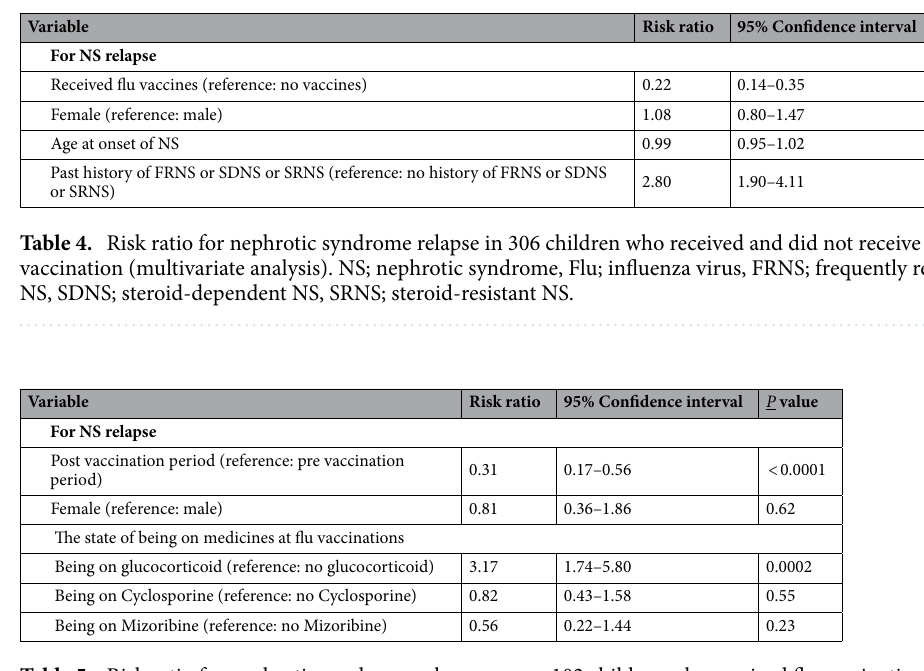
Table 5. Risk ratio for nephrotic syndrome relapse among 102 children who received flu vaccination (multivariate analysis). NS; nephrotic syndrome, Flu; influenza virus.